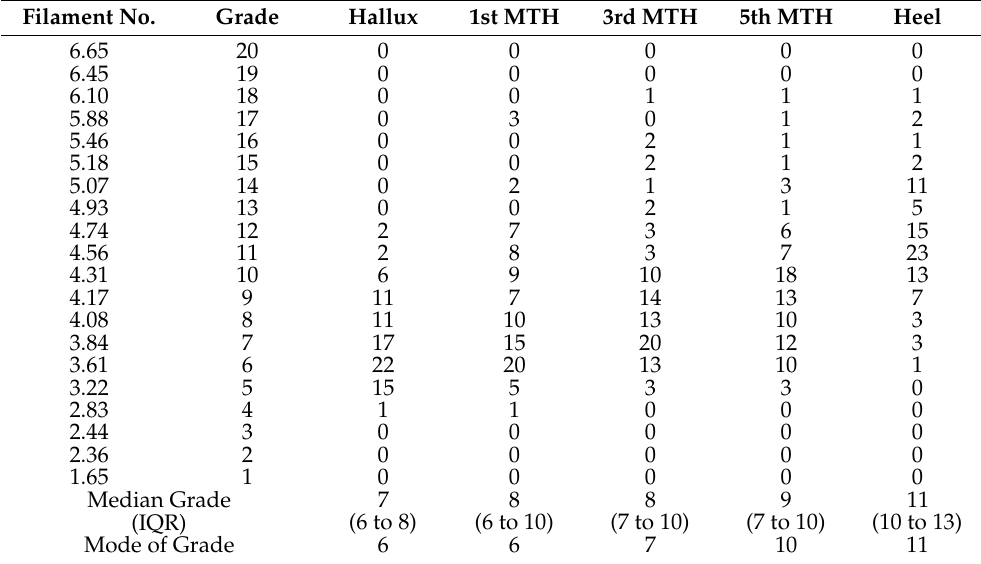
Table 2. Frequency distribution, median, interquartile range, and mode of the smallest perceivable grade for each test site.